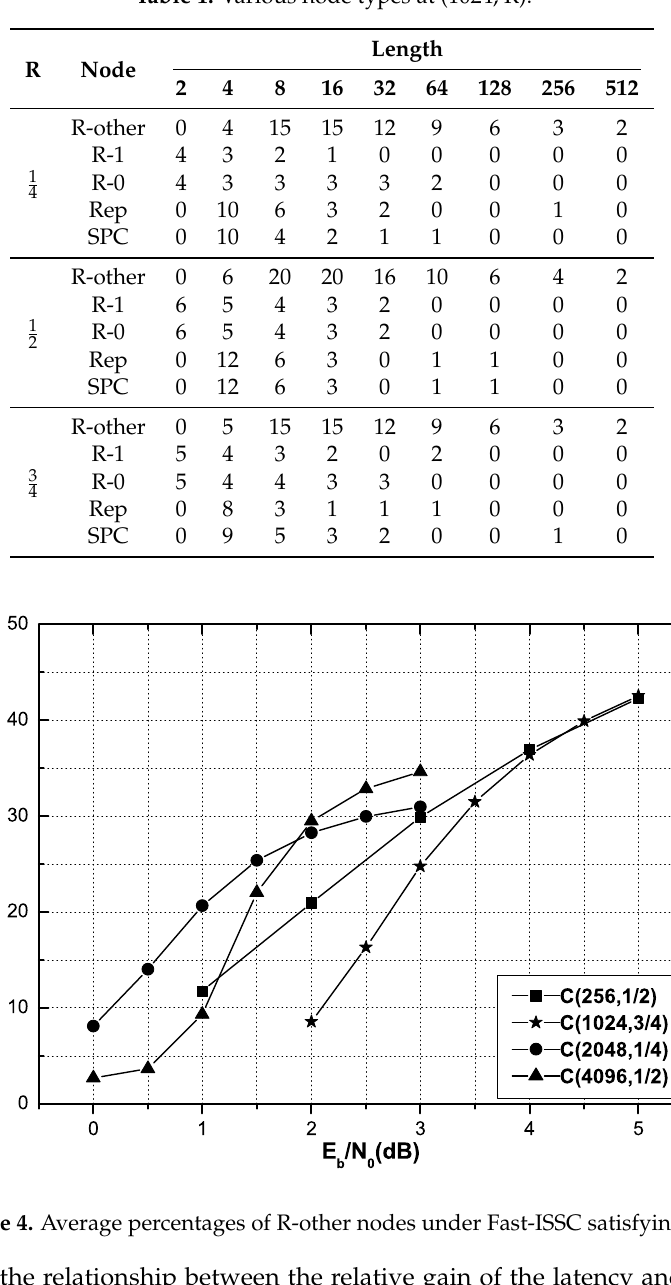
Table 1. Various node types at (1024, R).